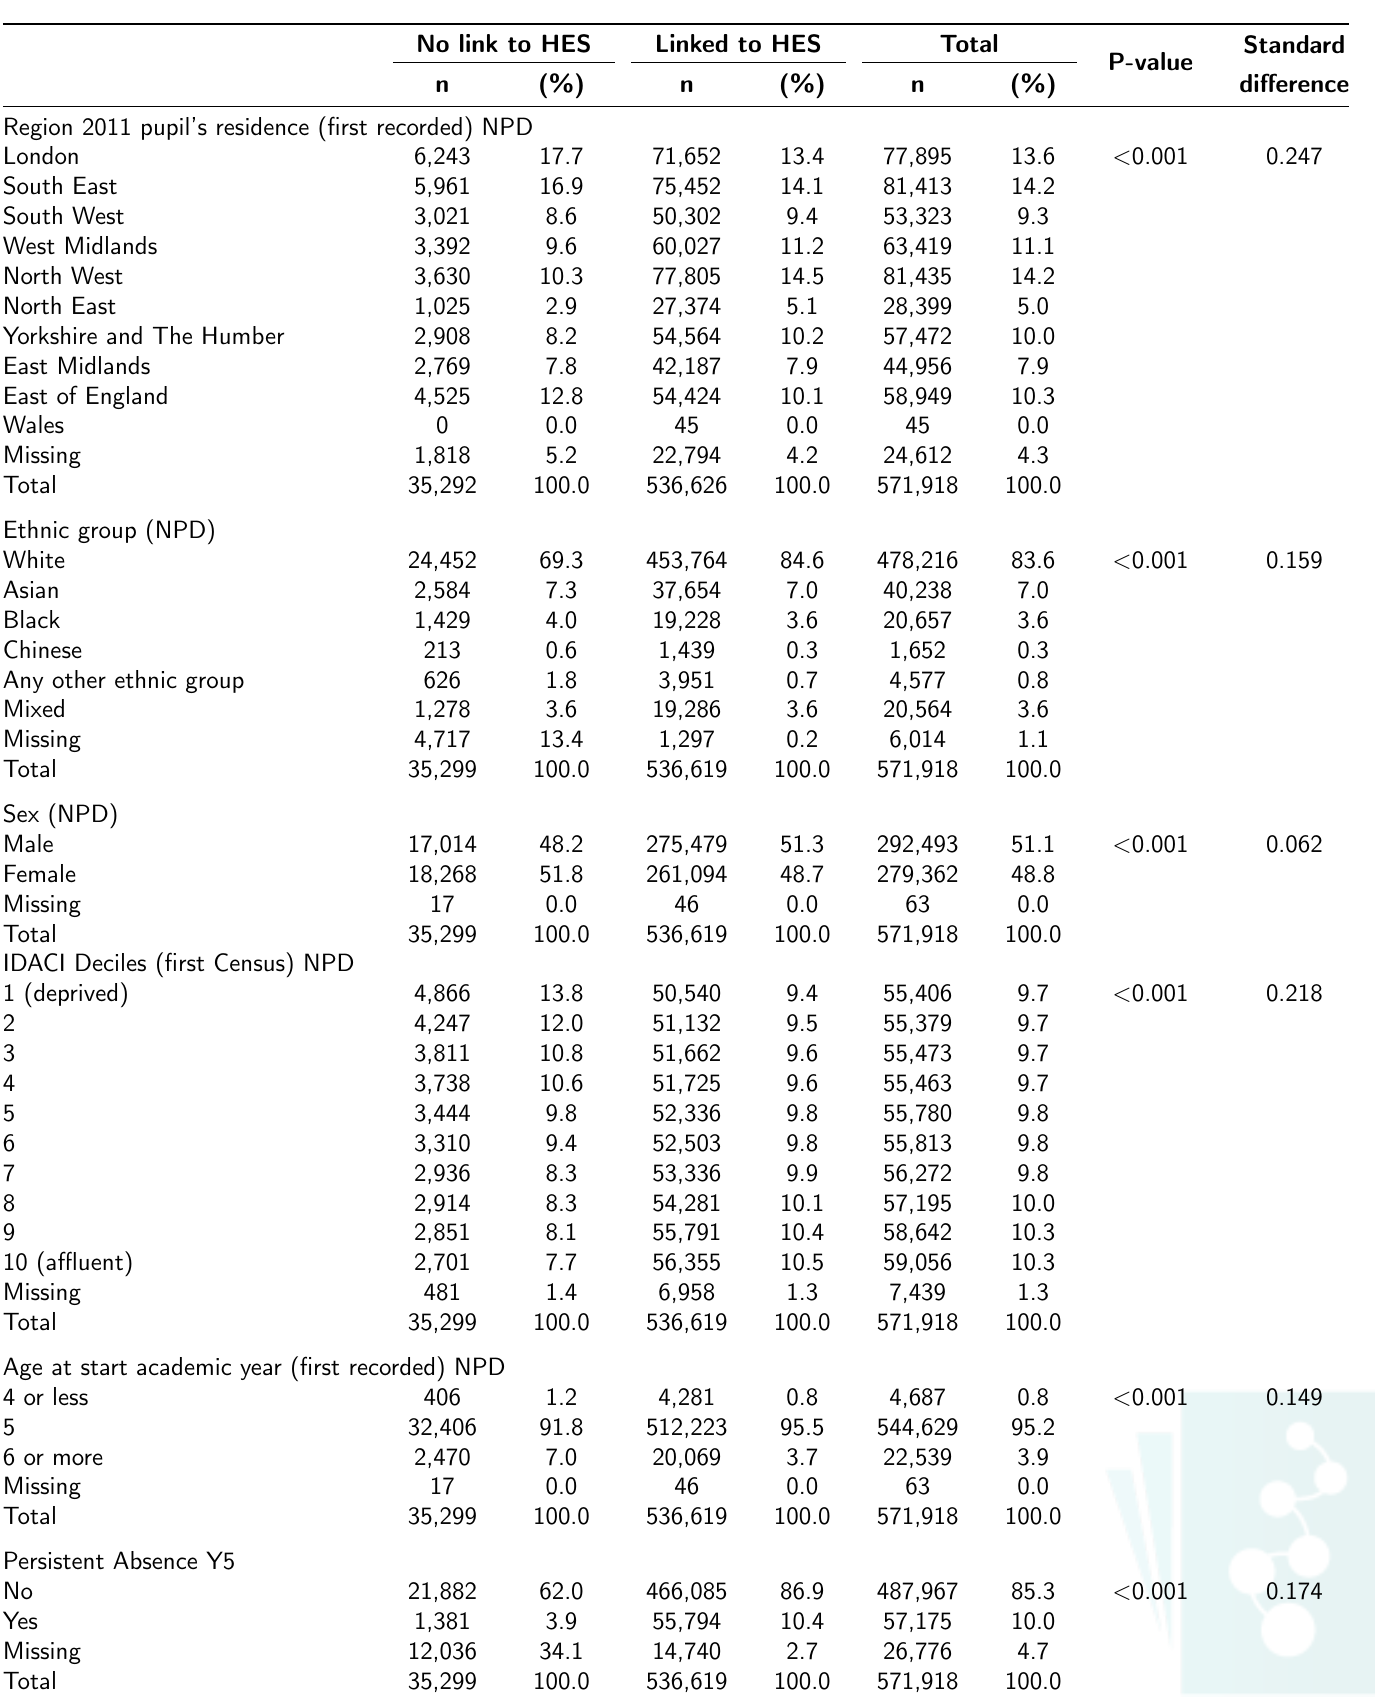
Supplementary Table 9.2: Distribution of demographic variables in national pupil dataset by linking status, N = 571,918 pairs (national pupil dataset to hospital episode statistics). Cohort